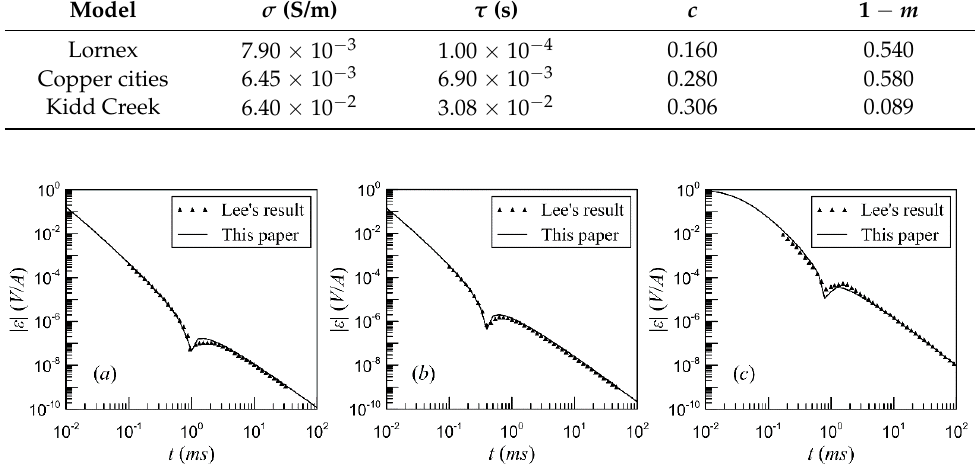
Table 1. Geoelectrical parameters of verification models.